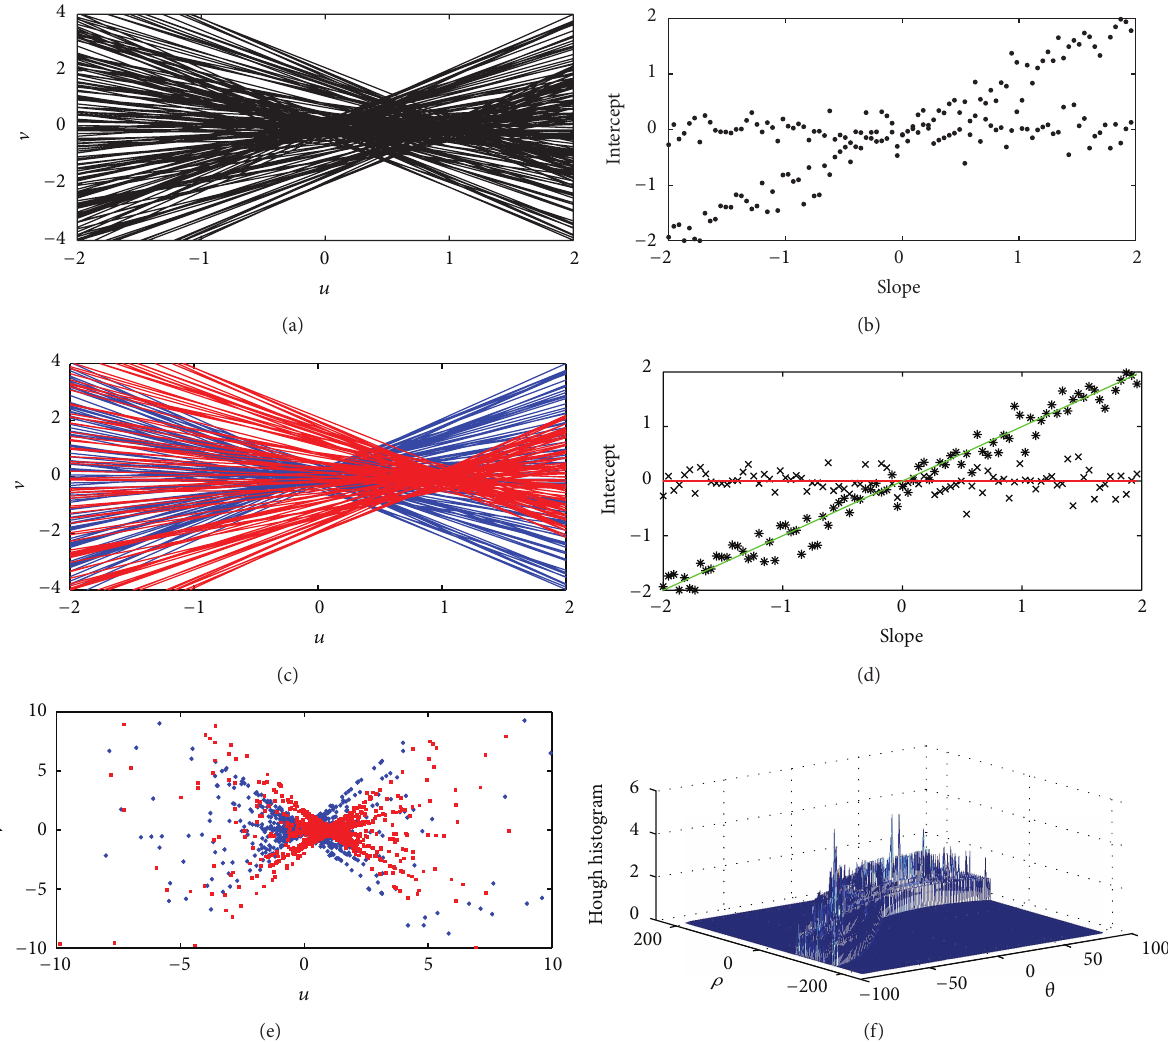
Figure 2: (a) Geometric representation of a 2D system of linear equations with two solutions. (b) The dual representation of the same system of linear equations in parameter space. In absence of an exact definition for a data structure, the underlying structures of these two figures can be visually interpreted in many different ways. (c) and (d) An interpretation of the above figures visualized based on linear models and added Gaussian noise. (e) Intersections of all the lines shown in (a) and (c) where blue and red markers represent the intersections of blue and red lines with themselves. (f) Histogram of putative solutions in the Hough